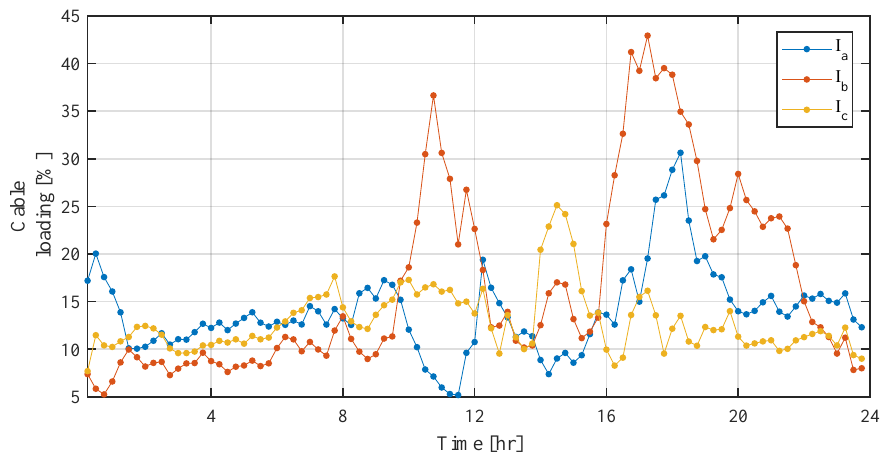
Figure 7. Estimated loading of cable C01 between nodes T2 and JB1.